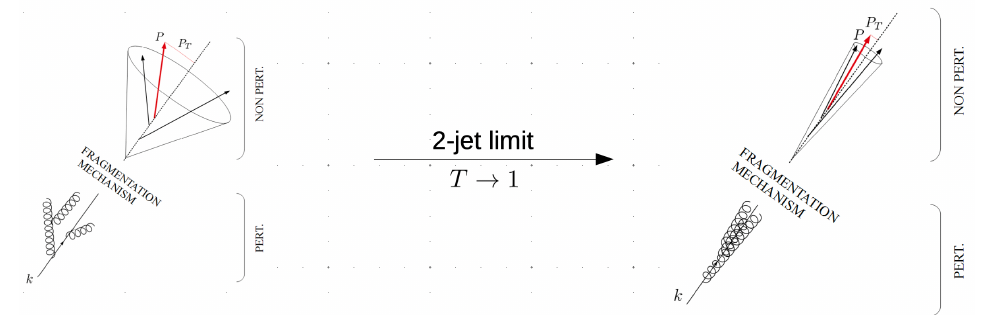
Figure 3: Pictorial representation of a TMD Fragmentation Function, in which the separation between perturbative and non-perturbative regime is explicitly shown, corresponding to two different values of the rapidity cut-off. On the right panel a very large value of the rapidity cut-off reproduces a 2-jet limit